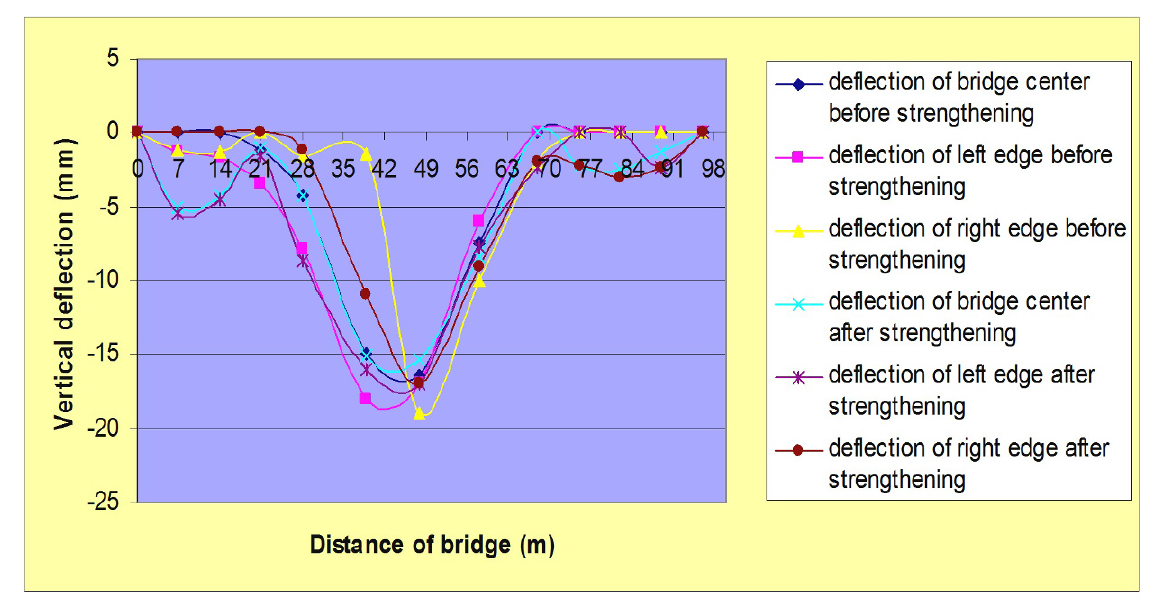
Figure 12. The values of vertical deflection before and after strengthening due to load combination I